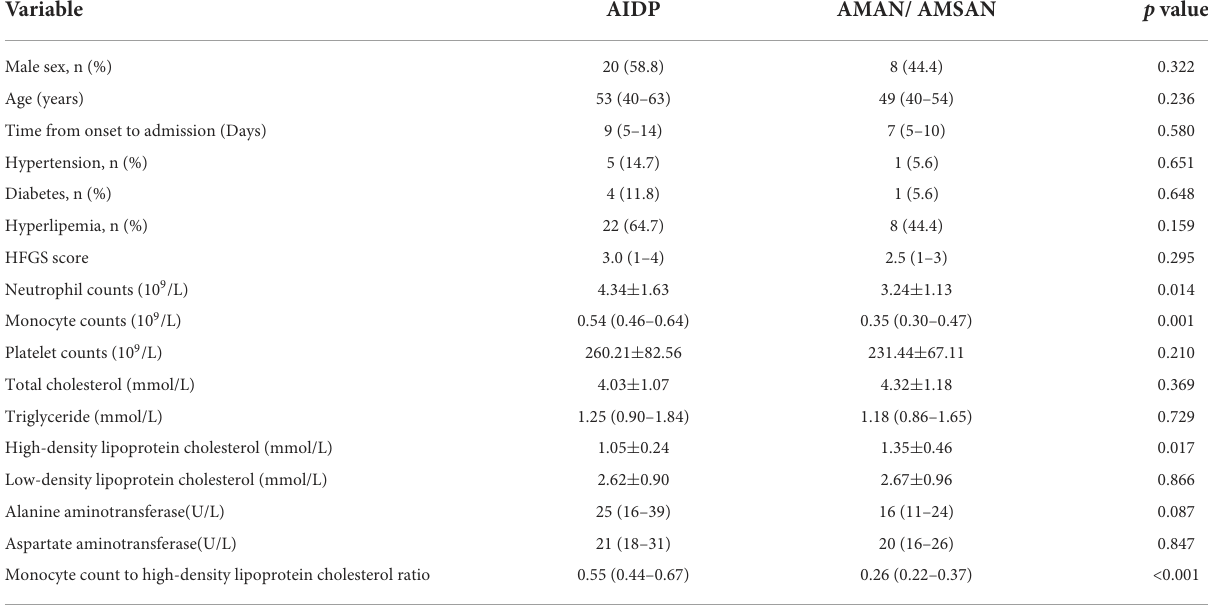
TABLE 1 The main characteristics in patients with different subtypes of GBS. Variable AIDP